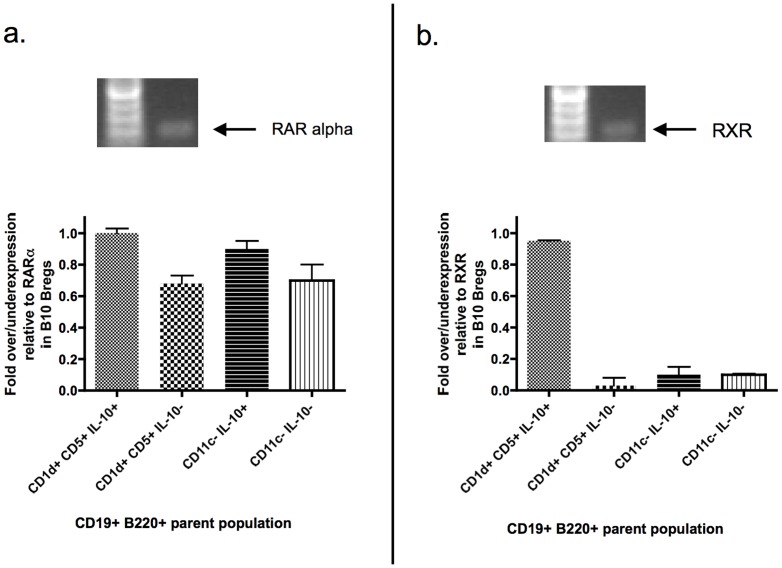
DC-Bregs and B10 Bregs express RA receptors.Real-time, semi-quantitative RT-PCR confirms the presence of steady-state mRNA of RA receptor alpha (Figure 7a) as well as low levels of retinoid X receptor (Figure 7b) in highly-purified (flow-sorted) DC-Bregs and B10 Bregs from freshly-isolated spleen of IL10gfp transgenic mice. The gel images in Figure 7a and 7b show the RT-PCR products from flow-sorted B10 Bregs. The steady-state mRNA levels of RARalpha and RXR from the B10 Bregs were used as the controls and the values were taken to represent 100% receptor expression. Steady-state mRNA levels of RARalpha and RXR in non-B10 Breg populations are shown in the graphs underneath the gel images normalised to the B10 Breg value and presented as fold under or overexpression. Steady-state RARalpha mRNA was detected in B10 Bregs (first bar in graph; leftmost)), IL-10− CD19+ CD5+ CD1d+ cells (second bar in graph), DC-Bregs (third bar in graph), and IL-10− DC-Bregs (last bar in graph; rightmost). The bars represent the medians and the error bars the SD. These data are representative of steady-state mRNA from flow sorted cells from two different spleens of age-matched mice (10 week-old females).